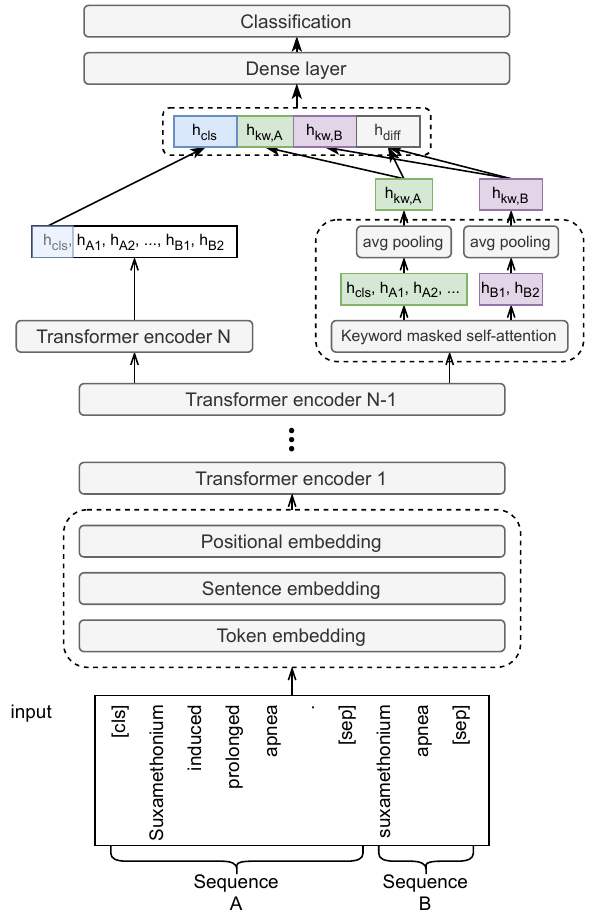
Figure 2. Neural architecture of Kw-BioBERT. A keyword-attentive layer is added in parallel with the last transformer encoder to represent the semantic interaction between the relation-suggestive tokens and entity